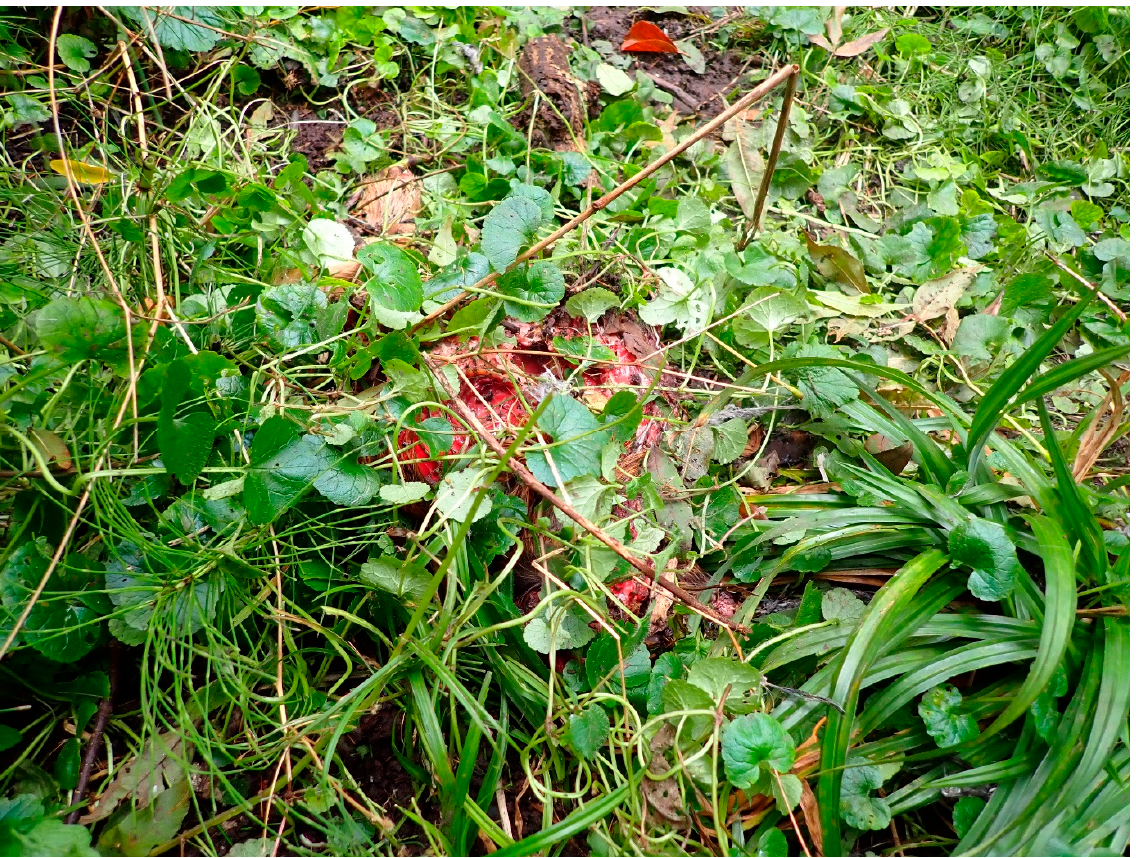
Figure 1. Parts of a deer carcass covered with plants by a Eurasian lynx in an experimental setting in Switzerland (Tierpark Bern).